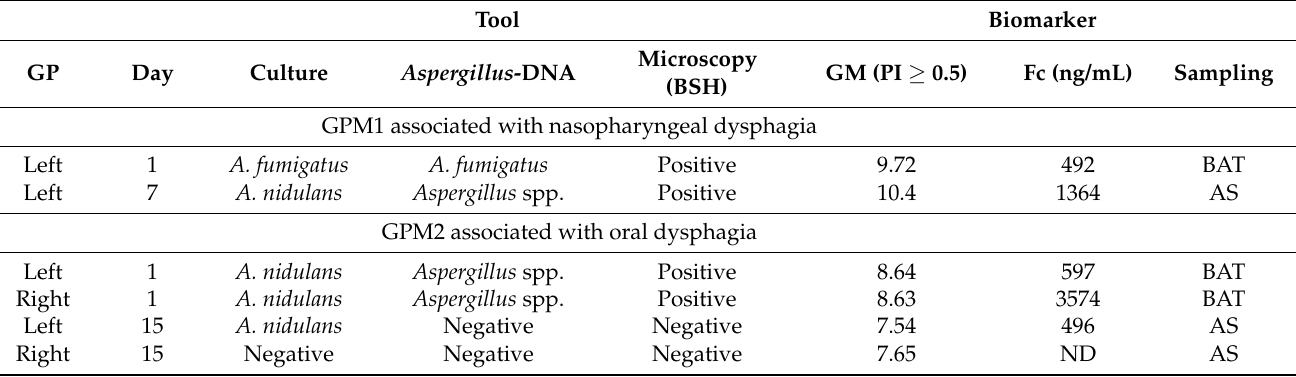
Table 3. Diagnostic tools and Aspergillus biomarkers in equine guttural pouch